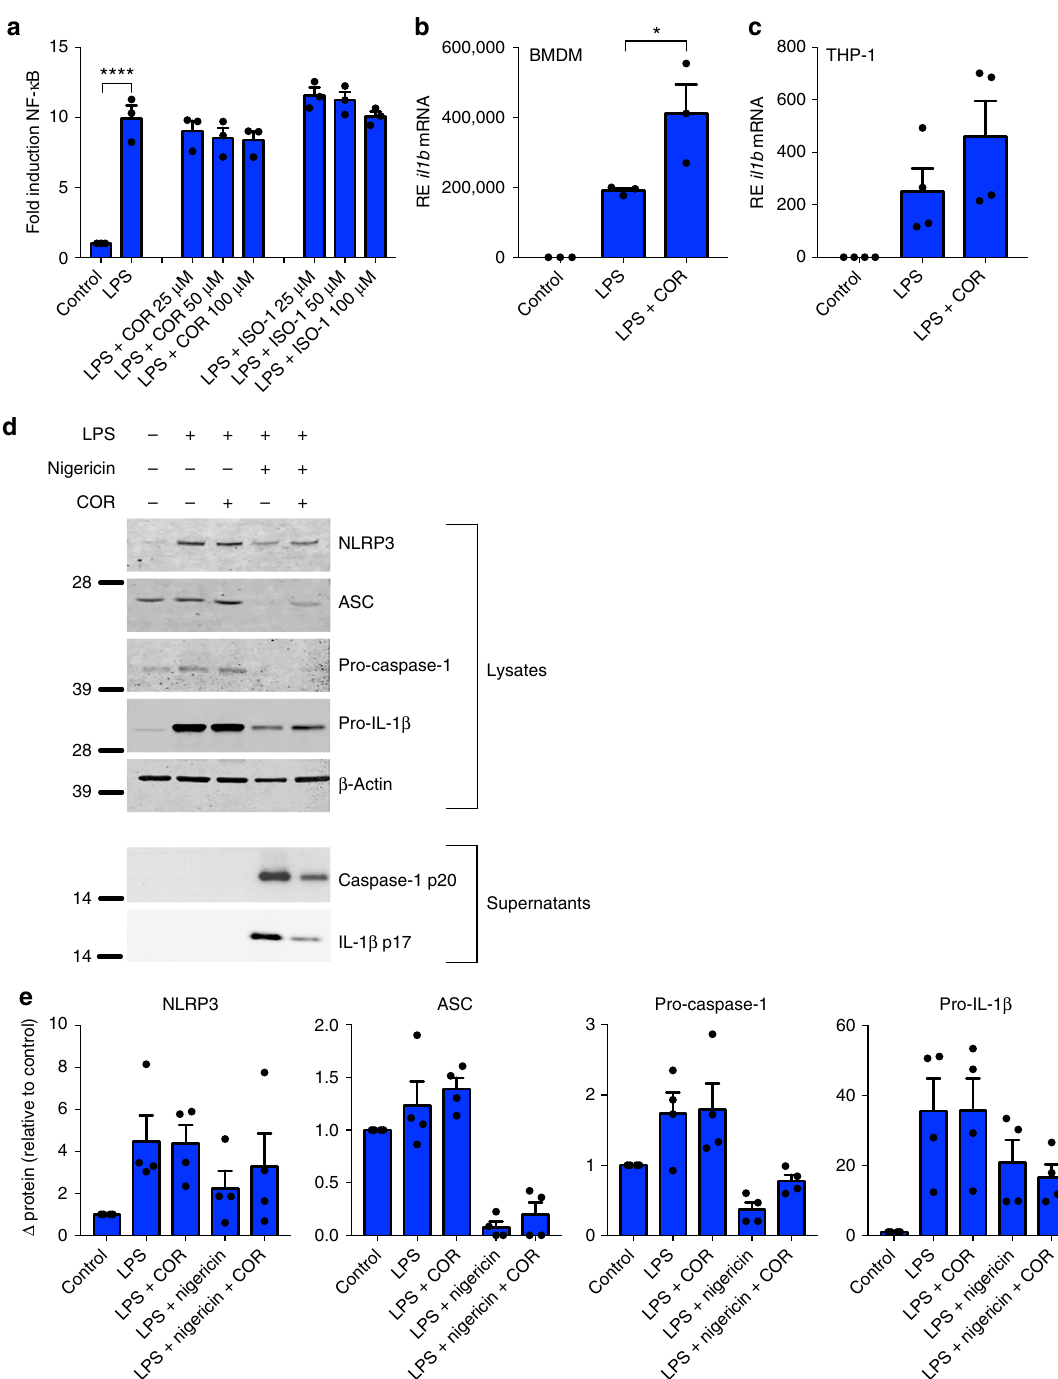
Fig. 4 Inhibition of MIF does not prevent transcription or translation of IL-1 β . a NF- κ B luciferase activity measured in RAW-ELAM macrophages pre-treated with COR123625 (50 µ M) for 1 h prior to priming with LPS (100 ng ml − 1 ) for 4 h. b Primary murine WT BMDM or c human undifferentiated THP-1 cells were left untreated, primed with LPS (100 ng ml − 1 ) alone for 4 h, or pre-treated with COR123625 (50 µ M) for 1 h before the addition of LPS. Relative expression (RE — relative to 18S) of il1b mRNA was quanti fi ed using real-time PCR. Data are mean ± SEM, n = 3 independent experiments. * P < 0.05, **** P < 0.001, one-way ANOVA with a correction provided by the Tukey's multiple comparisons test. d WT BMDMs were left untreated, primed with LPS